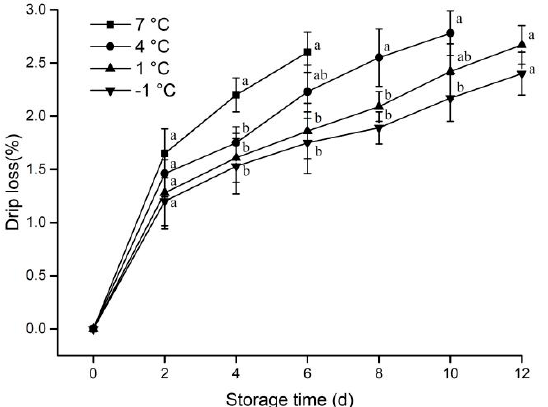
Figure 1. Effect of different storage temperatures on drip loss of pork. Different lowercase letters (a, b) indicate significant difference (p < 0.05) between each treatment on the same storage time .